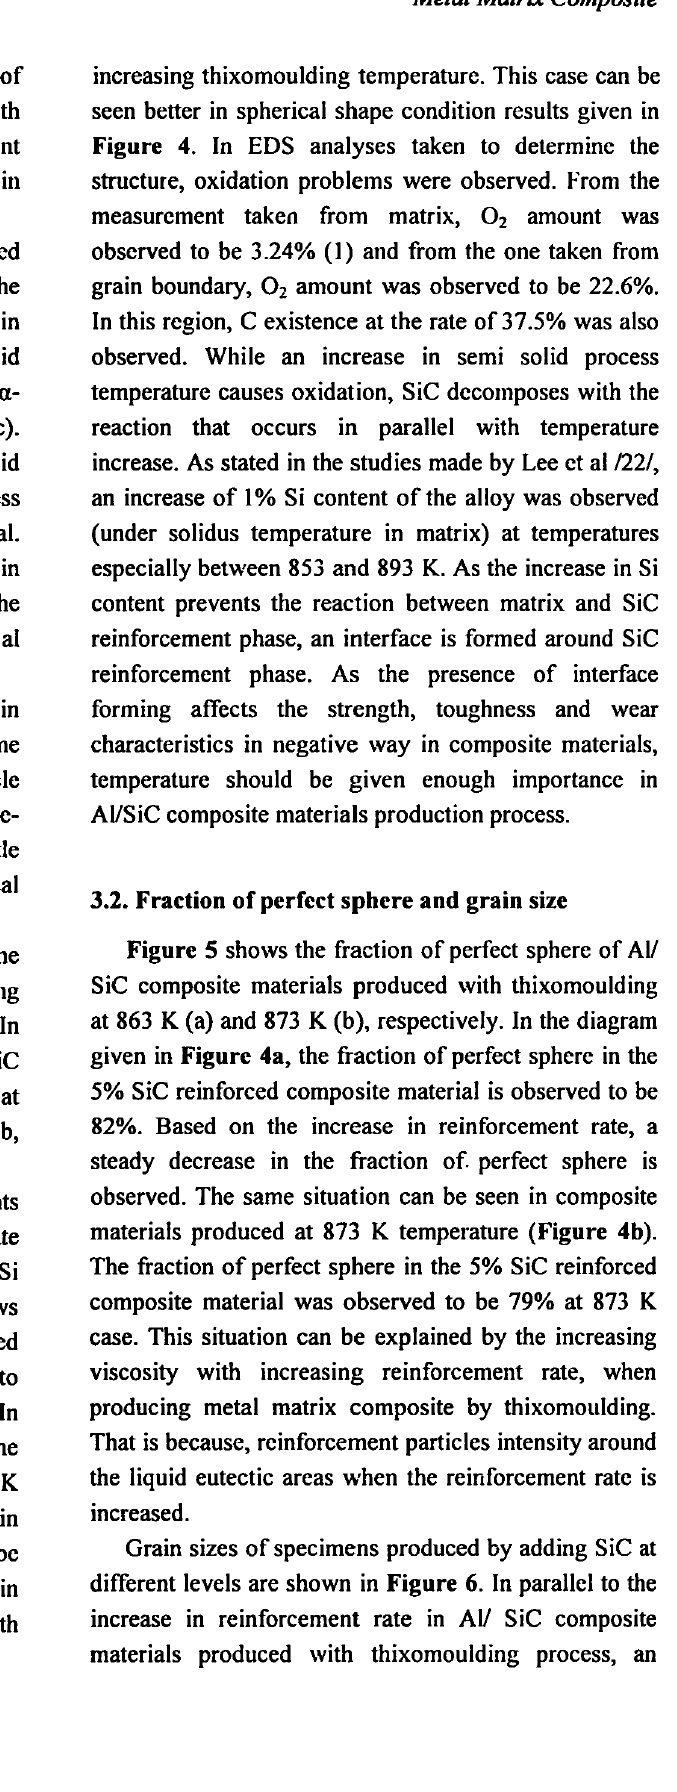
increasing thixomoulding temperature. This case can be seen better in spherical shape condition results given in Figure 4. In EDS analyses taken to determine the structure, oxidation problems were observed. From the measurement taken from matrix, O amount was 2 observed to be 3.24% (1) and from the one taken from grain boundary, O amount was observed to be 2